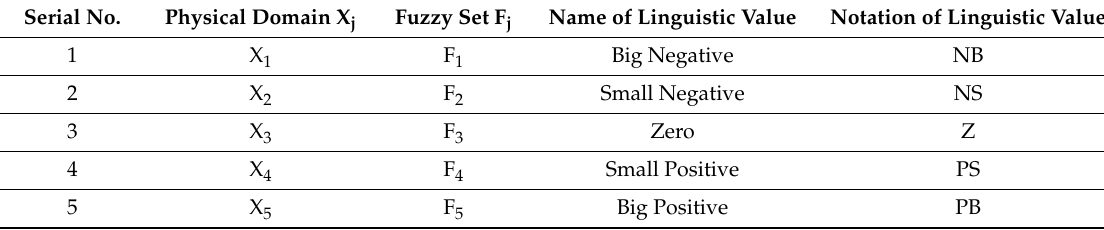
Table 2. Description of physical domains, fuzzy set and linguistic values of the inputs and outputs. Serial